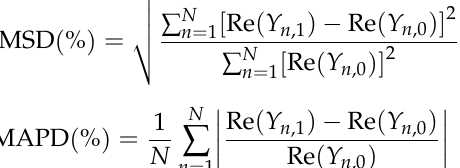
Figure 9. The damage metrics of the conductance and susceptance for SA-2 during the test. ( a ) RMSD, ( b ) MAPD. Figure 10. The damage matrices of the conductance and susceptance for SA-3 during the test. ( a ) RMSD, ( b ) MAPD.